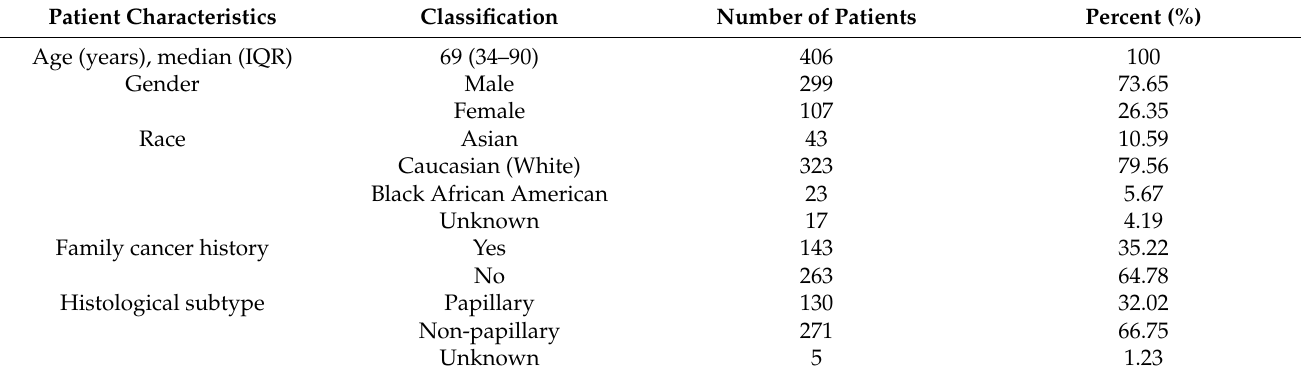
Table 1. Demographics and tumor characteristics of patients with BCa in the present study in terms of TCGA-BLCA. Patient